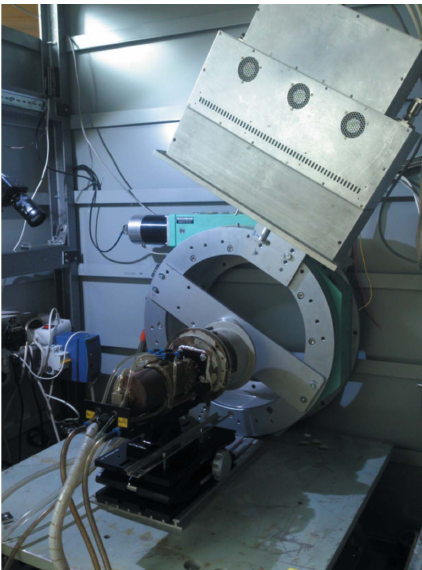
Figure 2 Working station 5b ‘diffraction movie’ at VEPP-3 with adapted experimental setup for study of phase formation dynamics during high- temperature synthesis in thermal explosion